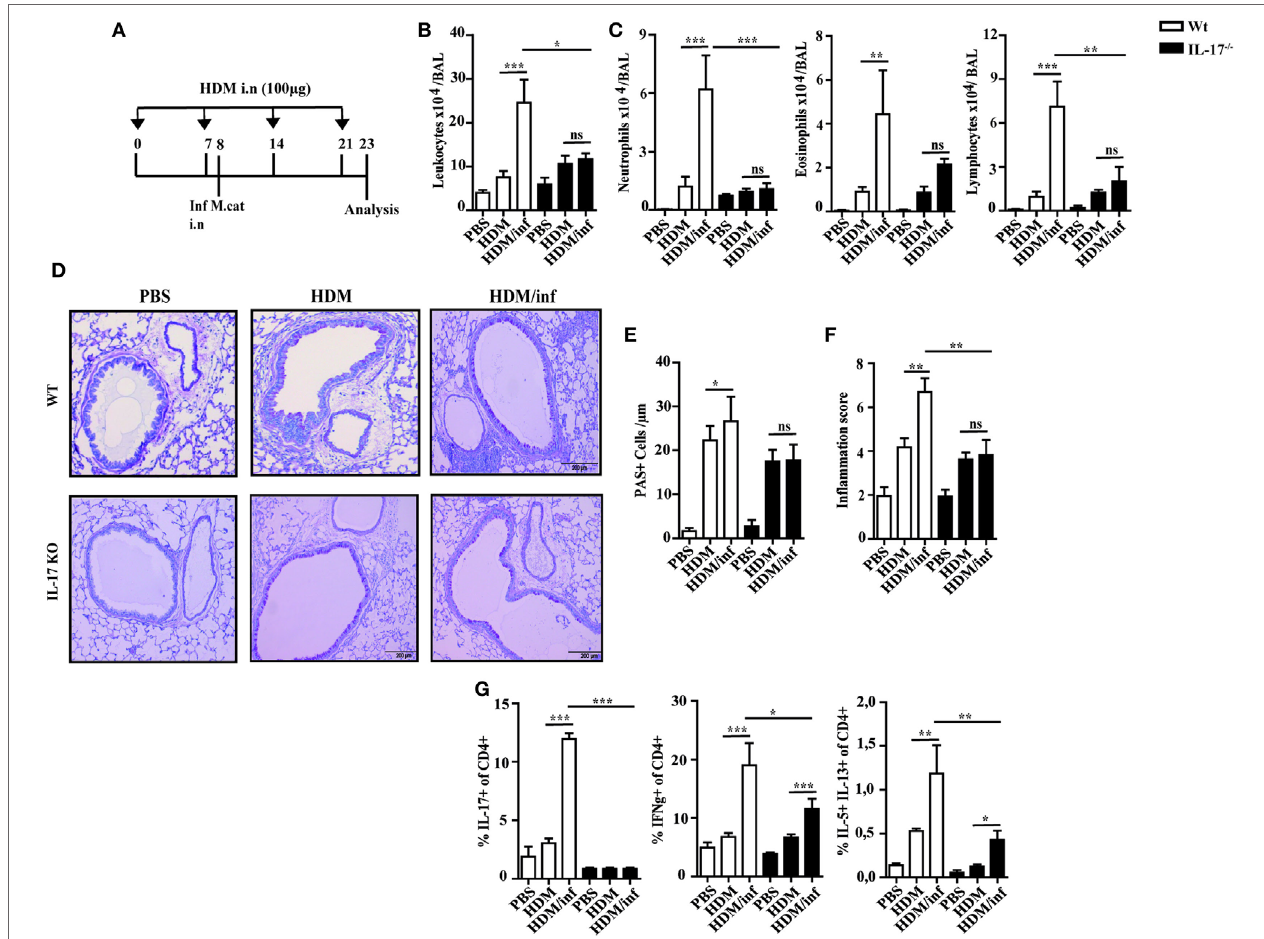
FigUre 5 | IL-17 is a key cytokine of M. catarrhalis -induced exacerbation of AAI. C57BL/6 (white bars) and IL-17 KO animals (black bars) were infected (i.n.) with 2 × 10 8 CFU M. catarrhalis after the second HDM exposure. BAL and lungs were analyzed at day 23. (a) Protocol. (B) Total cell counts in BAL. (c) Differential cell counts. (D) Representative periodic acid Schiff-stained airways. (e) Goblet cell counts in lung tissues. (F) Inflammation score. (g) Intracellular staining of CD4 + lung T cells for IL-17A, IFN- γ , IL-5, and IL-13. Data were from two independent experiments, n = 8 mice per group. *** P = 0.001, ** P = 0.01, and * P = 0.05 (one-way ANOVA). AAI, allergic airway inflammation; HDM, house dust mite; BAL, bronchoaleveolar lavage; ANOVA, analysis of